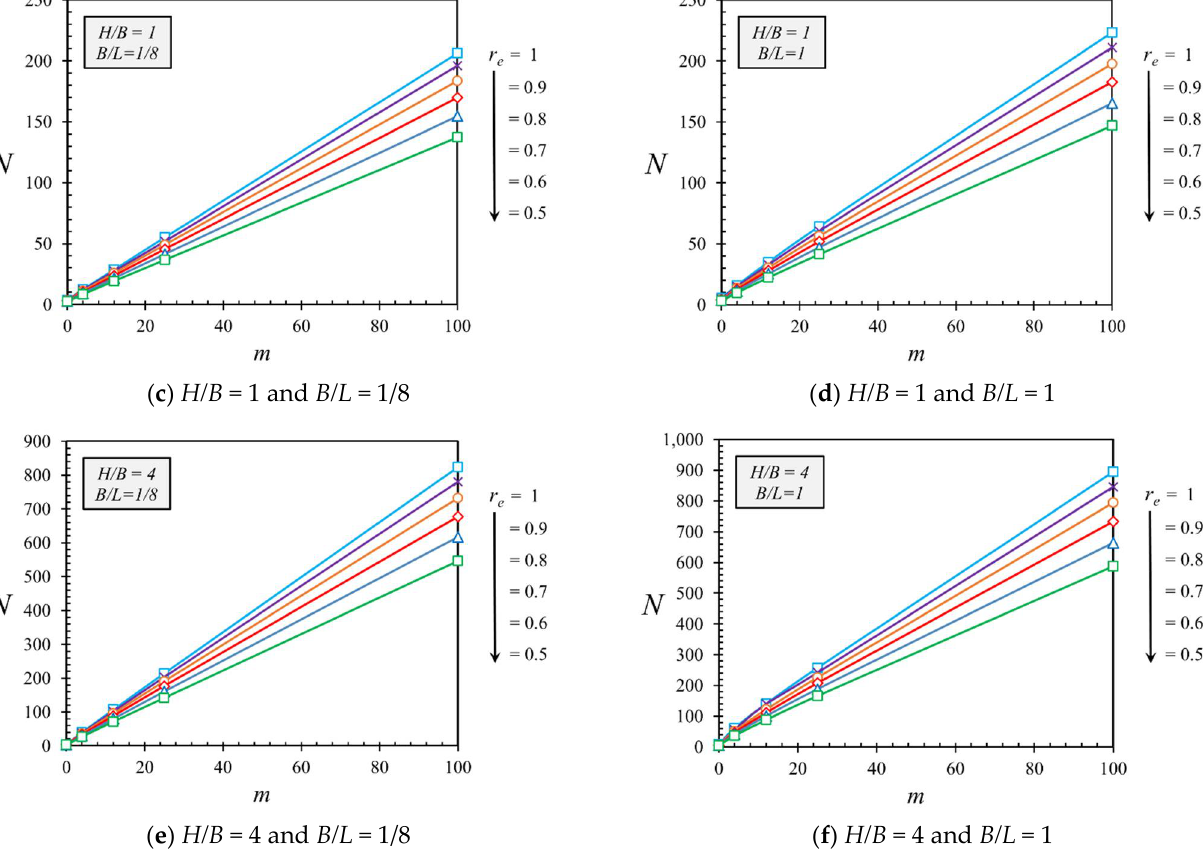
Figure 9. N vs. m for the various r e ( H / B = 0.5, 1.0, 4.0 and B/L = 1/8, 1).